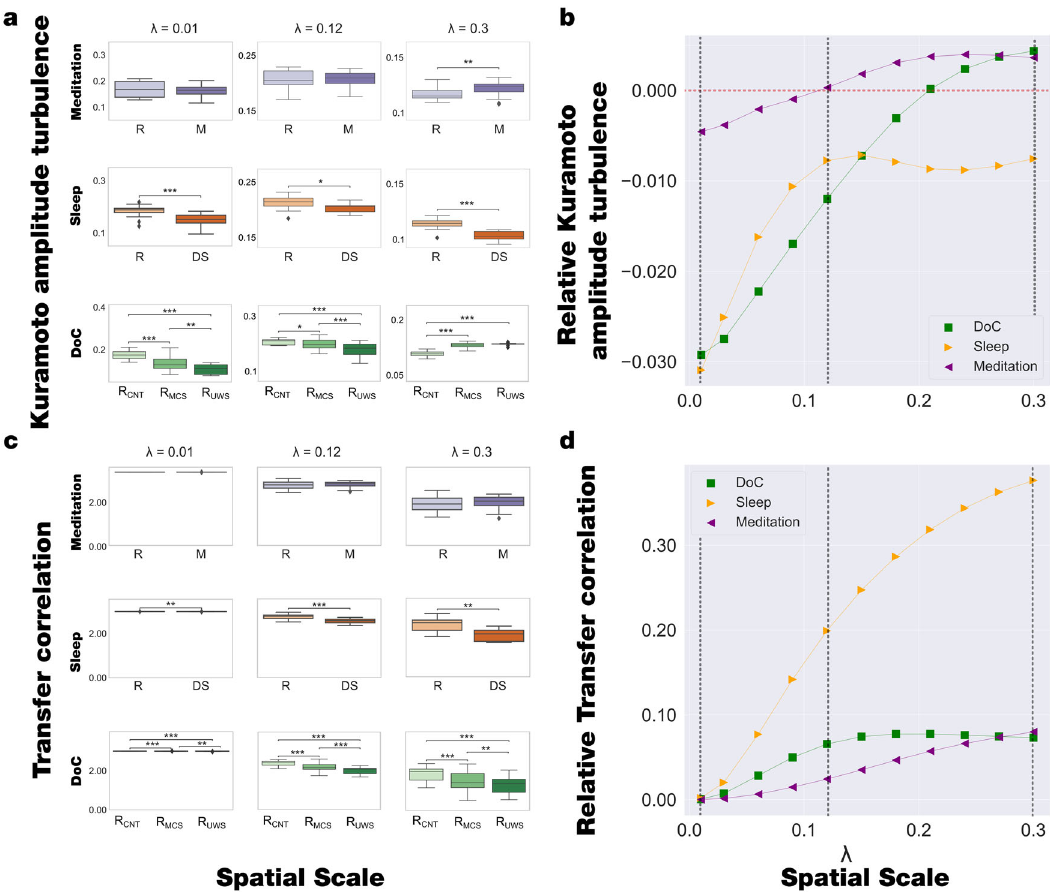
Fig. 2 Model-free framework reveals signi fi cant differences in Kuramoto amplitude turbulence and transfer correlation in different brain states. a The plots show the level of Kuramoto amplitude turbulence at different spatial scales, from λ = 0.01 (100 mm) to λ = 0. 3 (3 mm) in steps of 0.03, and show the comparison between brain states for λ = 0.01, λ = 0.12 and λ = 0.3. The meditation state showed signi fi cant increases in Kuramoto amplitude turbulence compared to the resting state only on higher scales. The DS shows signi fi cantly lower Kuramoto amplitude turbulence than the resting state across all spatial scales. By contrast, the Kuramoto amplitude turbulence showed signi fi cant decreases in R MCS and R UWS states in lower lambda scales but signi fi cant increases in higher scales compared to R CNT . b The plots were computed as the linear fi t of the mean level of Kuramoto amplitude turbulence at each scale for the three brain states for the DOC dataset (i.e., R CNT , R MCS , and R UWS ) and two brain states for sleep and meditation datasets (i.e., W, DS, and R, M, respectively). The plots display the obtained slopes as a function of the scale. In particular, DOC showed negative slopes at lower scales and increased with the scales up to positive slopes. The sleep dataset presented negative slopes at lower scales, increased up to λ = 0.12, and a negative slope value was kept almost constant. The meditation dataset also increased with scale but presented less variability than the other datasets. Dashed vertical lines indicate the scales displayed in A and the horizontal red dashed line highlights the zero slope. c We computed the transfer correlation ( |A λ | ) , which measures how the information travels across space at different spatial scales, i.e., we show the results as a constant k - |A λ |, with k = 3 |A λ |. The meditation state presents no signi fi cant differences on any scale compared to the resting state. In contrast, the transfer correlation signi fi cantly decreased for DS and R MCS , R UWS states compared to the resting state across all scales. d We performed the same computation as in panel B for the transfer correlation measure. In this case, DOC and sleep datasets presented a similar slope-scale relationship, whereas the meditation dataset presented less variability across scales. In the fi gure, P-values were assessed using the Wilcoxon rank-sum test and corrected for multiple comparisons, * P < 0.05, ** P < 0.01 and *** P < values, i.e., from 0.01 (~100 mm) to 0.30 (~3 mm), in steps of 0.03. This measure was de fi ned as the standard deviation across time ( t ) and space (brain areas, n ) of the local Kuramoto order parameter. We found that the meditation state increases Kur- amoto amplitude turbulence levels in higher spatial scales, i.e., short distances in the brain, compared to the resting state. On the other hand, the deep sleep state shows lower Kuramoto amplitude turbulence levels than the resting state across all the spatial scales. Finally, the Kuramoto amplitude turbulence levels decrease for DOC patients (R MCS and R UWS ) compared to healthy controls during resting state in lower lambda values, i.e., long distances, but increases in higher lambda scales; differentiating, also, between the R UWS and R MCS groups. The results of Kuramoto